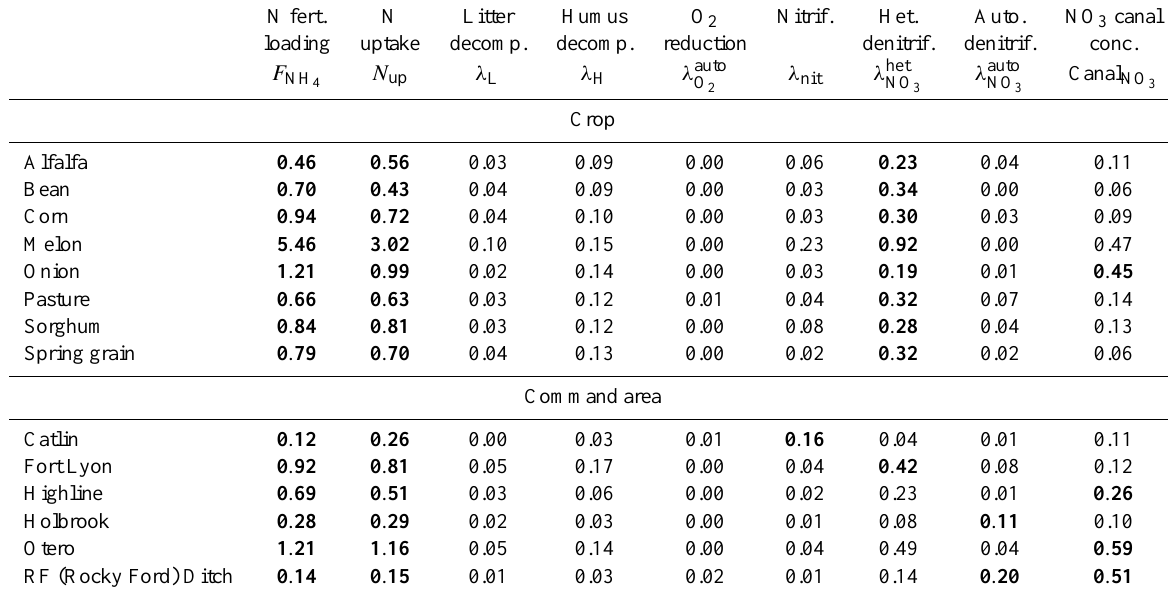
Table 3. Sensitivity index ( µ ∗ ) for each of the model input factors investigated, indicating the degree of parameter influence on C NO shallow saturated zone of the aquifer (in layer 4 of the grid) for the grid cells associated with each crop type and command area, with the values of the top three influential parameters for each crop type and command area in bold.